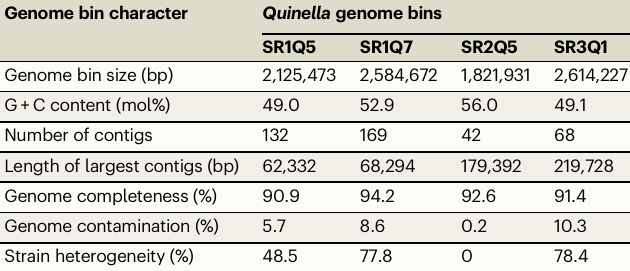
Table 2 | Quinella genome bins Genome bin